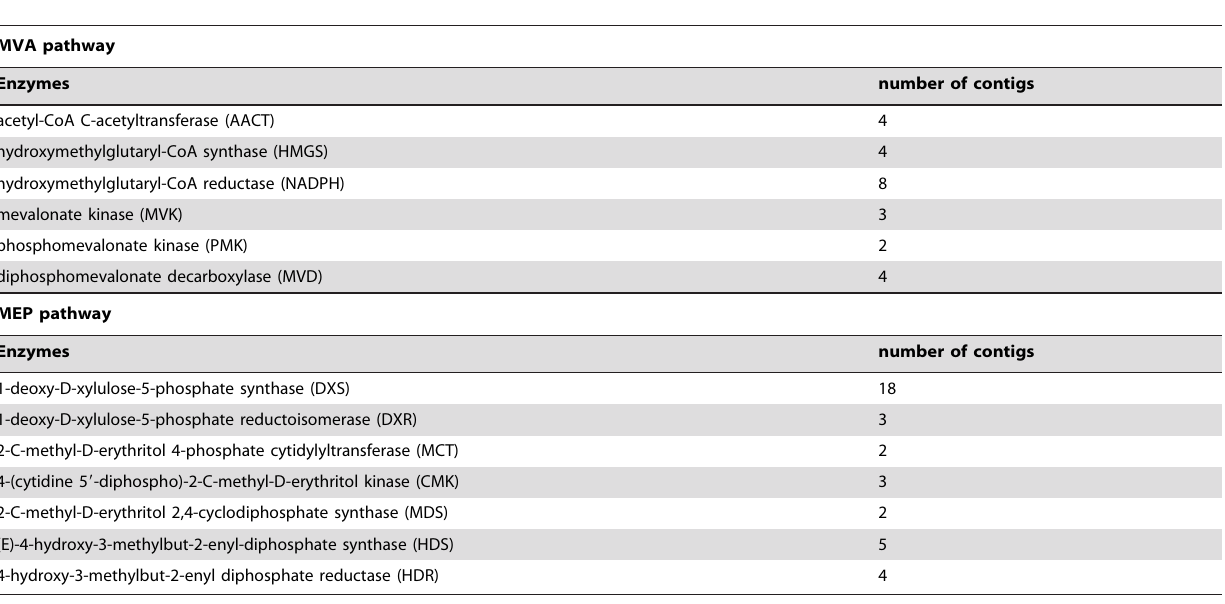
MVA pathway Enzymes